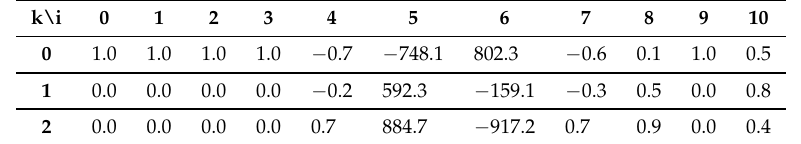
coefficients. ki